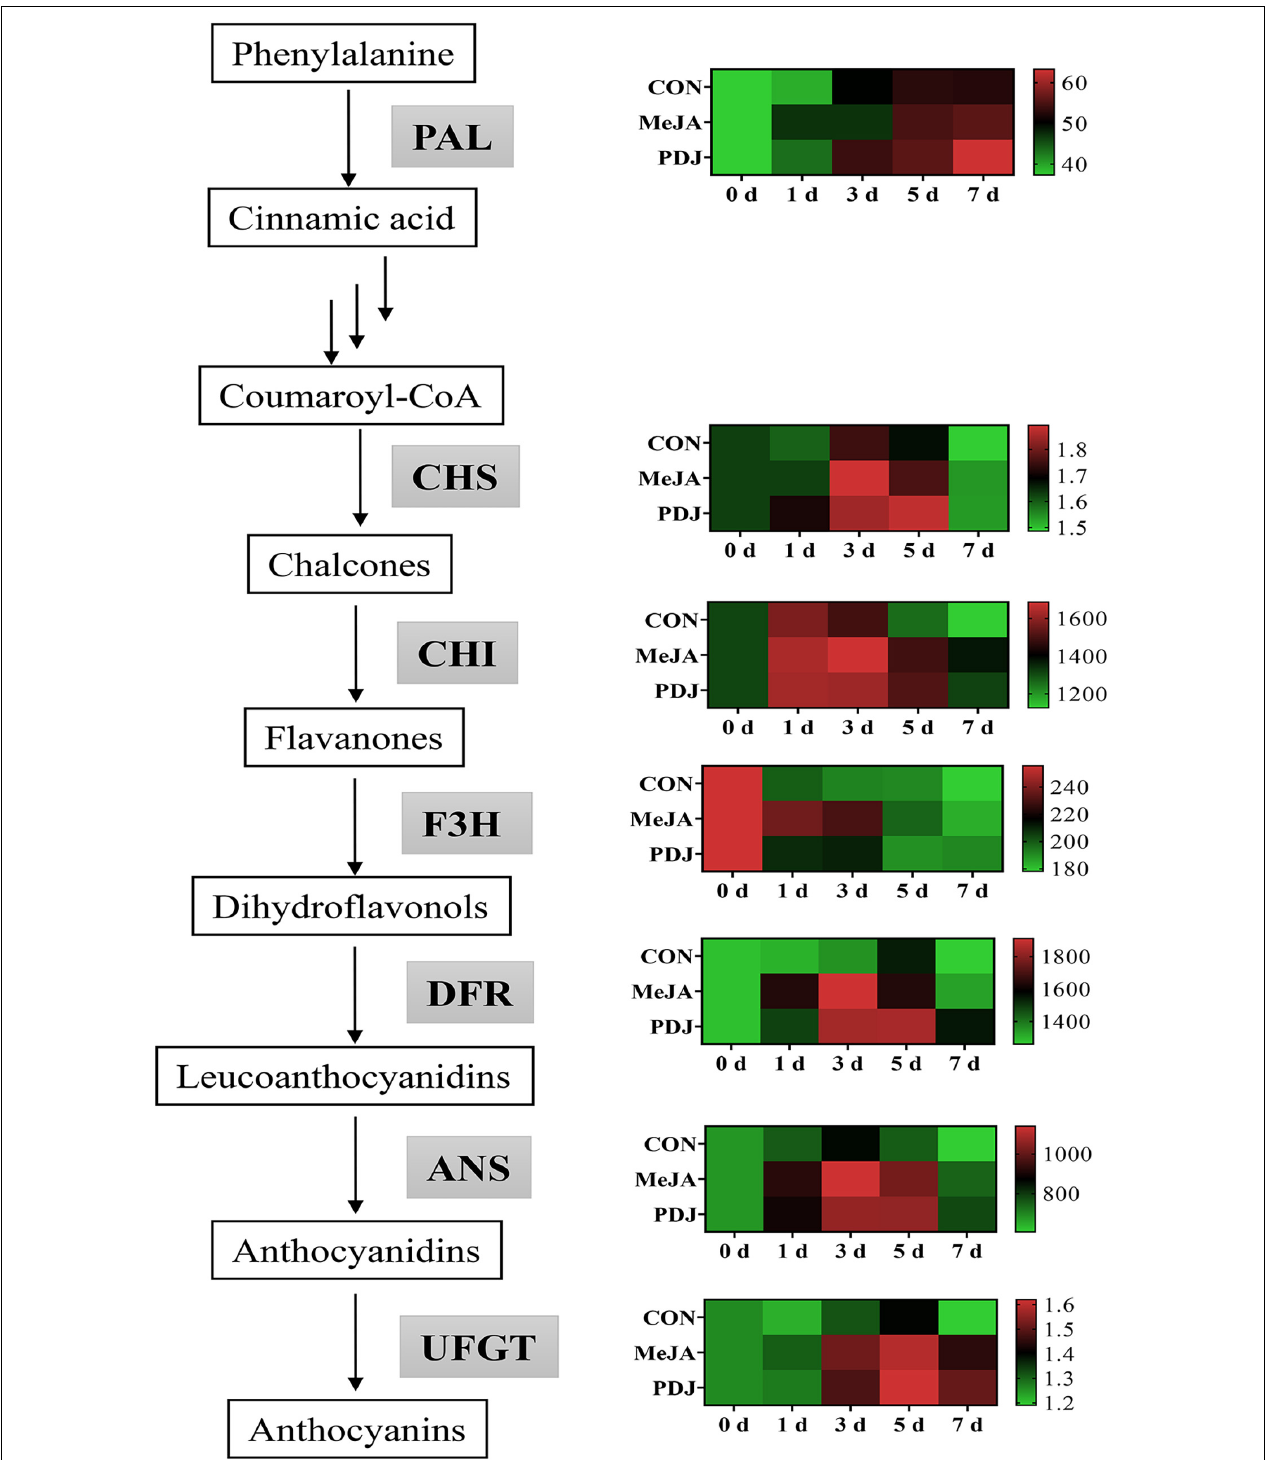
FIGURE 4 | Heatmap showing the effects of postharvest jasmonate treatments on the of the activities of anthocyanins biosynthesis enzymes in peach skin during storage (22 ± 2 ◦ C; light intensity 300–400 lux). The color gradient scale to the right of each chart (green-black-red), represents low, middle, and high values of enzyme